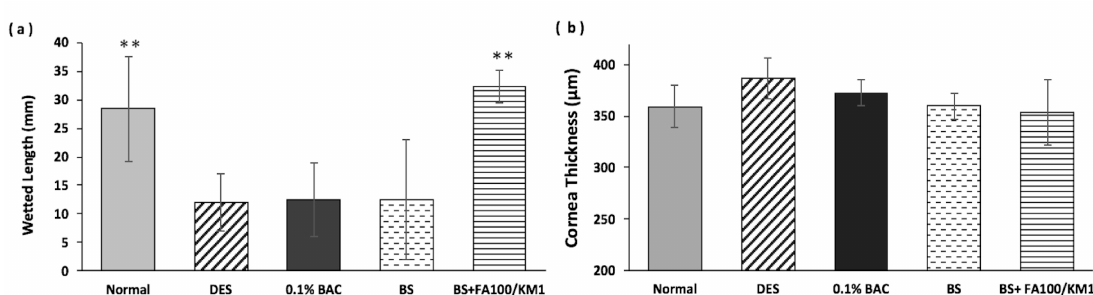
Figure 5. Results of ( a ) Schirmer’s tests for tear production, ( b ) corneal thickness variation in all treated groups. All groups were compared to the dry eye syndrome (DES) group for statistical analysis ( n = 4, ** p < 0.01).